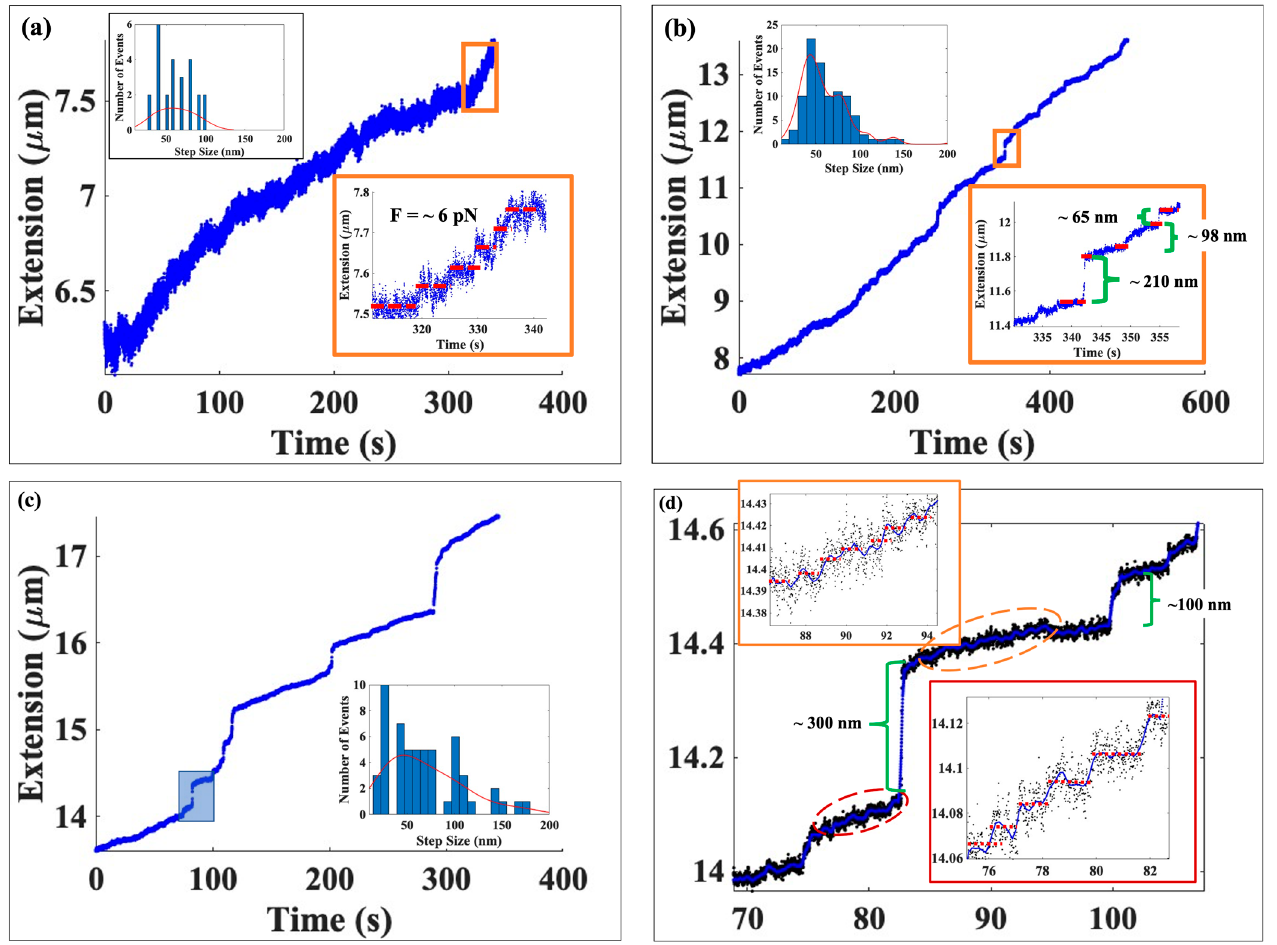
Figure 2. ( a ) Extension vs. time graph displaying data from about 6.2 µ m to about 7.8 µ m from Figure 1 corresponding to a force range we refer to as the low force regime. Starting with the DNA’s extension at ~6.2 µ m, we began to increase the force by bringing the magnet nearer to the tethered, suspended bead. The force was gradually increased, causing the DNA to extend. The inset on the lower right of the figure shows the data for ~6 pN at a higher resolution. Although a staircase-type profile is clearly evident in the data, we extracted protein steps using a bilateral filter; the fits are shown by the red dashed lines in the inset. The histogram, which is shown in the upper left of the figure, depicts the total number of disassembly events detected in this force range. ( b ) plots extension as a function of time from ~7.8 µ m to ~13.5 µ m, corresponding to forces of ~6 pN to ~25 pN. These data are for the case where force is increased at a low loading rate, same as for the data in ( a ). Insets additionally show the zoomed-in area of the extension vs. time as well as the step-size histogram (right bottom and top left respectively). ( c ) presents data for DNA extensions between ~13.5 µ m to ~17.4 µ m from the experiment shown in Figure 1 when force was increased from ~25 pN to the point where the tether underwent the overstretching transition, ~65 pN. We observed 53 unbinding events, which are plotted in the step-size histogram—see inset at the bottom left. ( d ) shows a zoomed-in portion of the region within the shaded rectangle in panel ( c ). Further high-resolution data for portions of the data in panel ( d ) are given in the two insets. The lower right inset is taken from the lower dashed oval while the upper left inset present data from the upper dashed oval. In both sets, step-like features are clearly